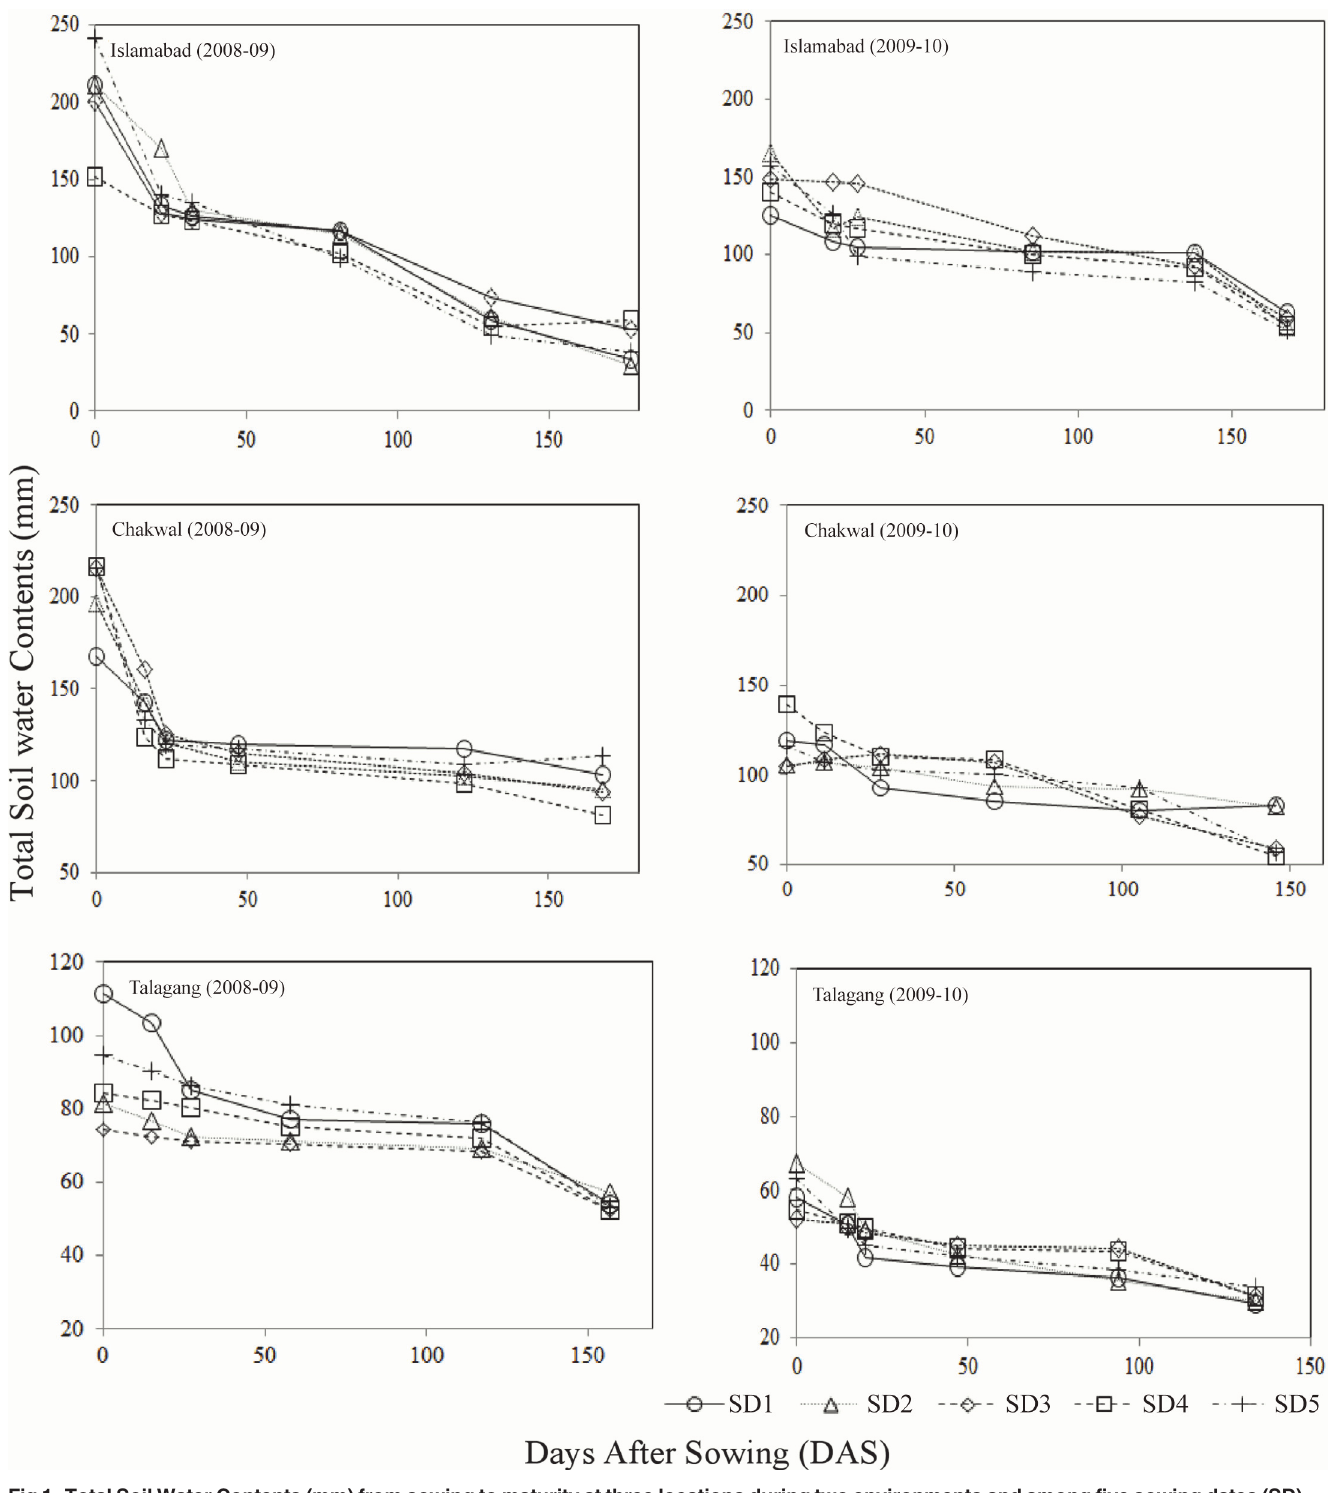
Fig 1. Total Soil Water Contents (mm) from sowing to maturity at three locations during two environments and among five sowing dates (SD).